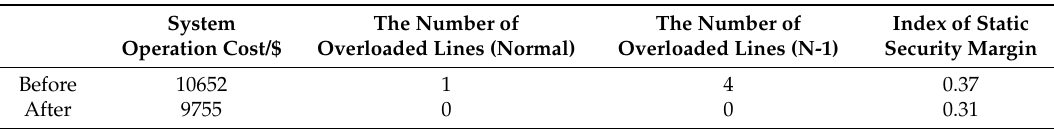
Table 4. The comparison of system economic efficiency and static security index before and after